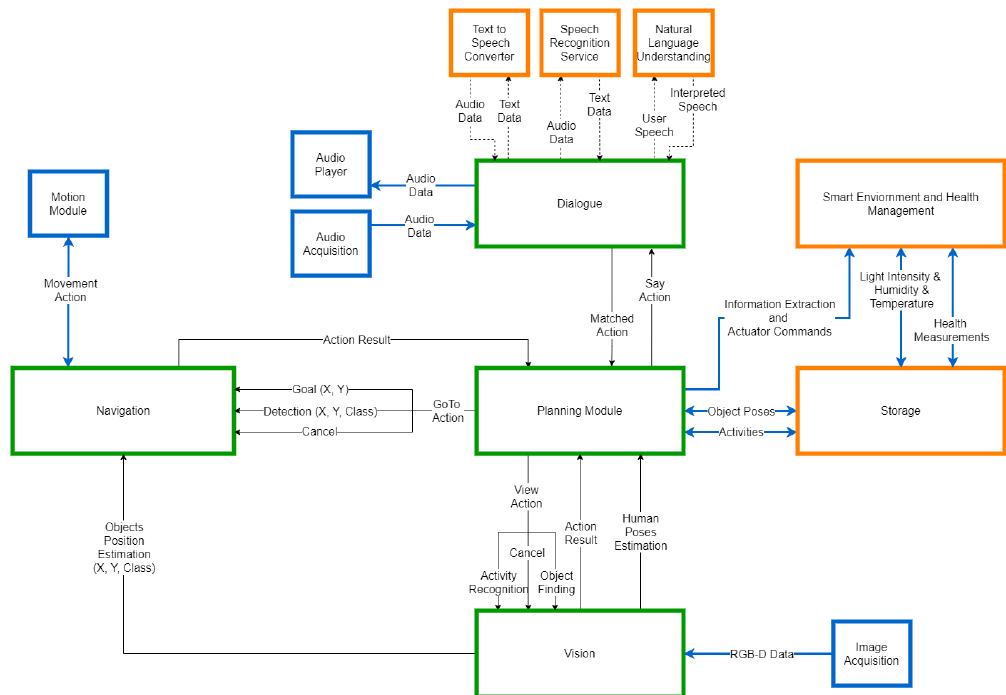
Figure 1. AMIRO System Architecture—block diagram. The green boxes represent the cloud-edge components, orange boxes represent cloud services, and blue boxes represent modules operating on the robot. If the arrow between boxes is black, then it represents an internal call, if is dotted it represents a call to a cloud service and if it is blue arrows then it symbolizes a communication through